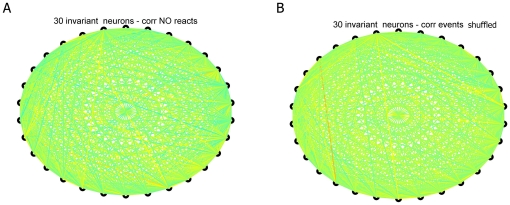
Comparison of correlations during reactivations, outside reactivation
and during reactivation with shuffled neural activities.(A) No weak correlation coefficient among 30 top neurons
belonging to intensity-invariant units outside reactivation periods;
(B) no significant correlation with shuffled neural
activities.